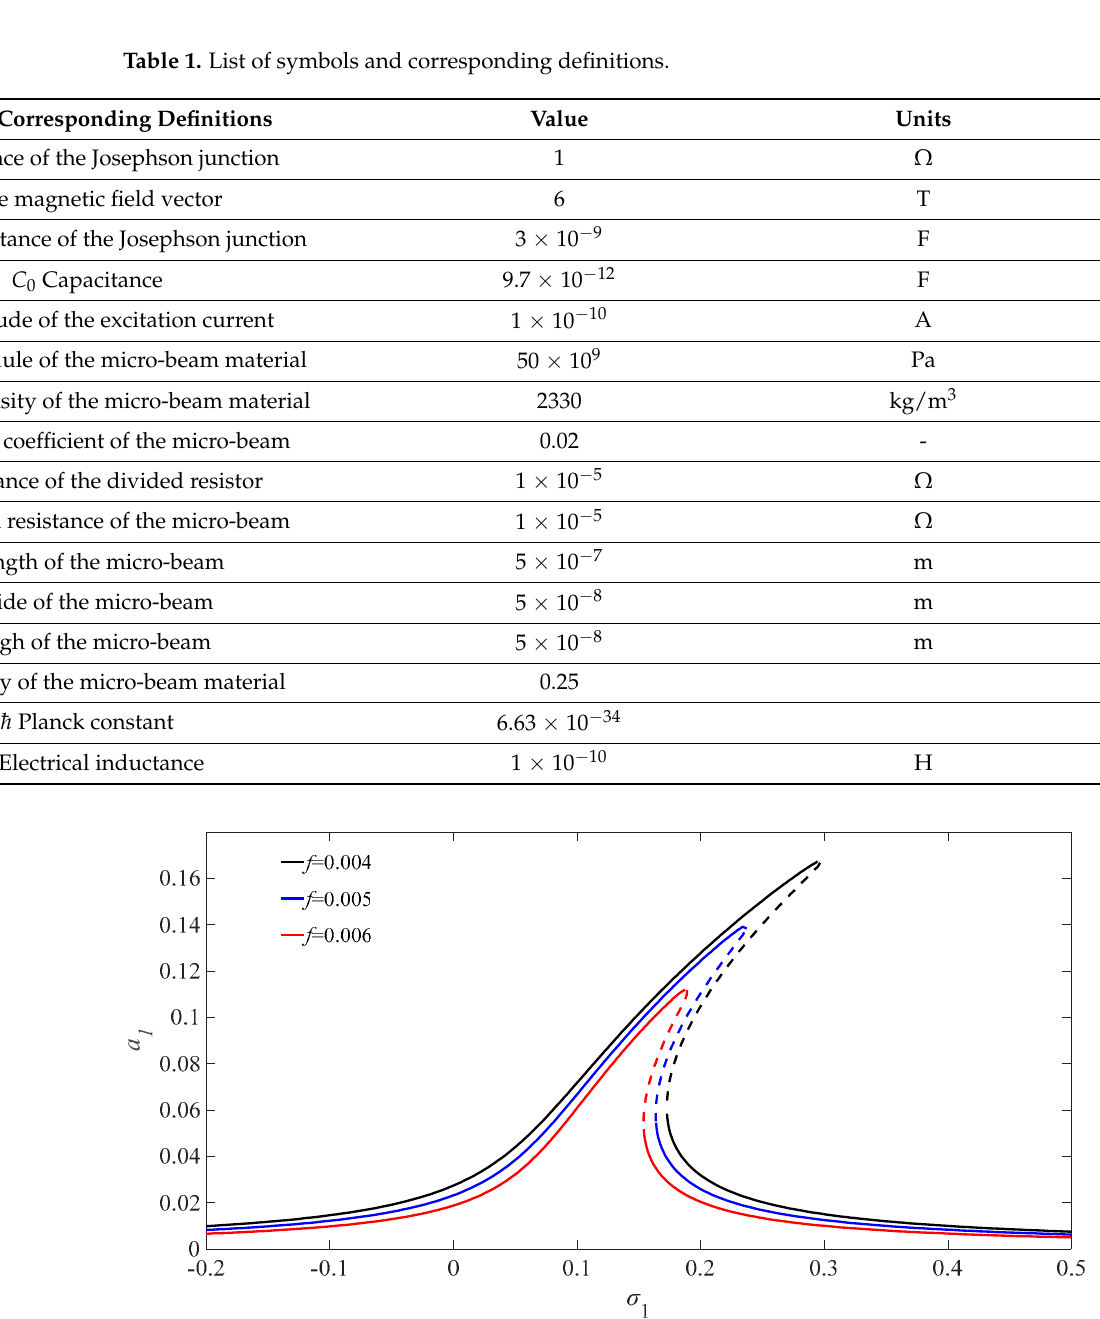
Figure 2. Internal resonant amplitude-frequency diagram of PDJJ for different excitation amplitudes. The amplitude–frequency diagram of the circuit charge for different phase difference of the Josephson junction is shown as Figure 3. The amplitude of the circuit charge of the Josephson junction first increases and then decreases with the increase in the tuning parameters. There is no multi-valued phenomenon in the solution of the charge equation, and the solution of the equation has a stable vibration